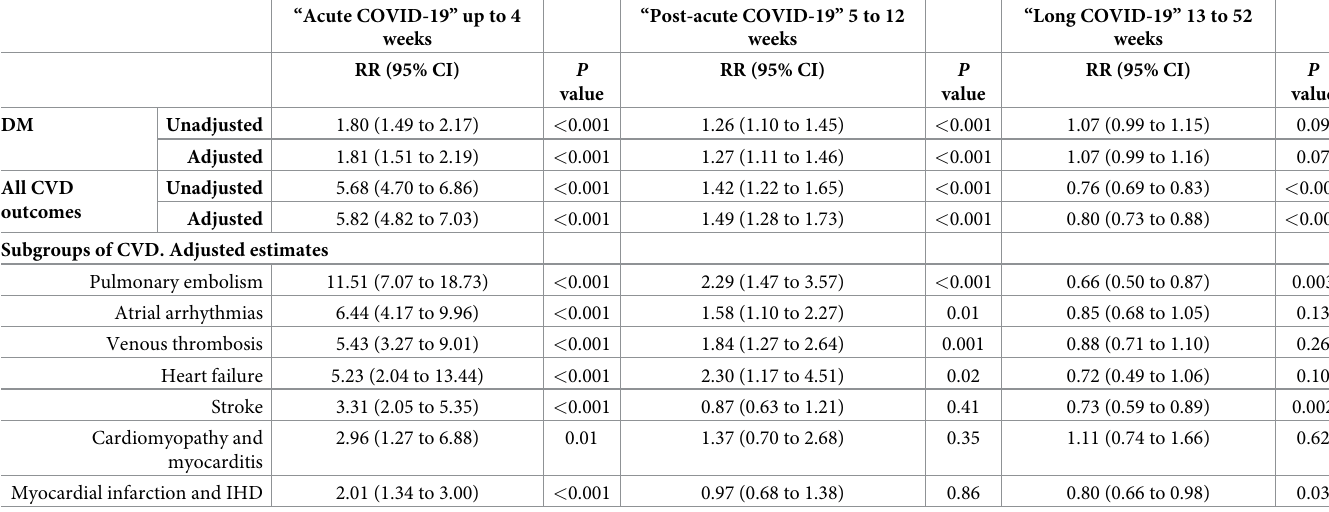
Table 3. Results of difference-in-difference analysis showing net effect of COVID-19 over baseline rate and comparison with controls. (Estimates were adjusted for age, ethnicity, smoking, BMI category, SBP category, Charlson score, index month, and matched